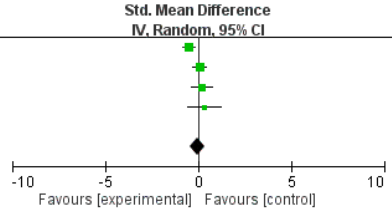
Figure 4. E ff ect of yoga on anxiety symptoms in comparison to non-mindful exercise. Figure 4. Effect of yoga on anxiety symptoms in comparison to non-mindful exercise.